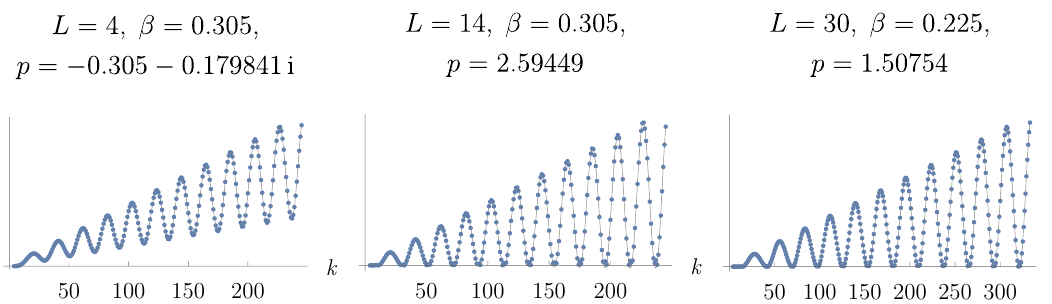
Figure 1 . The k -dependence of jh MPS j (cid:9) M =2 ij for three example values of L , (cid:12) and p , together with (cid:12)tted ans(cid:127)atze